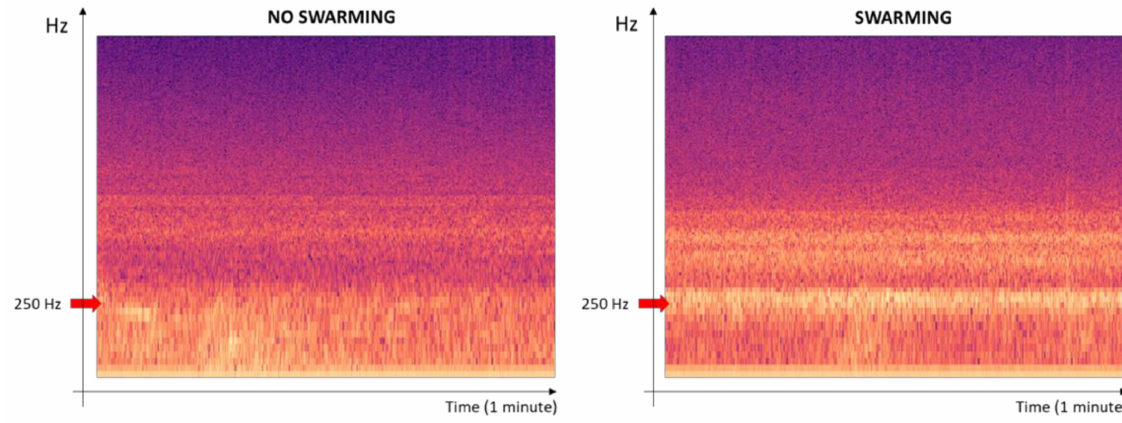
Figure 3. Swarming and non Swarming Mel spectrograms. The left image is during a non-swarming event, and the right image is five days before a swarming